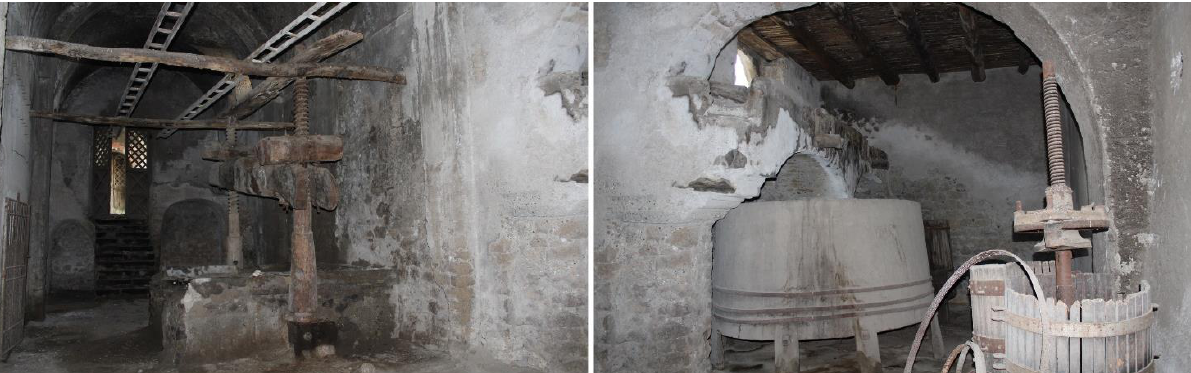
Figure 8. The cellar with the ancient machinery for squeezing